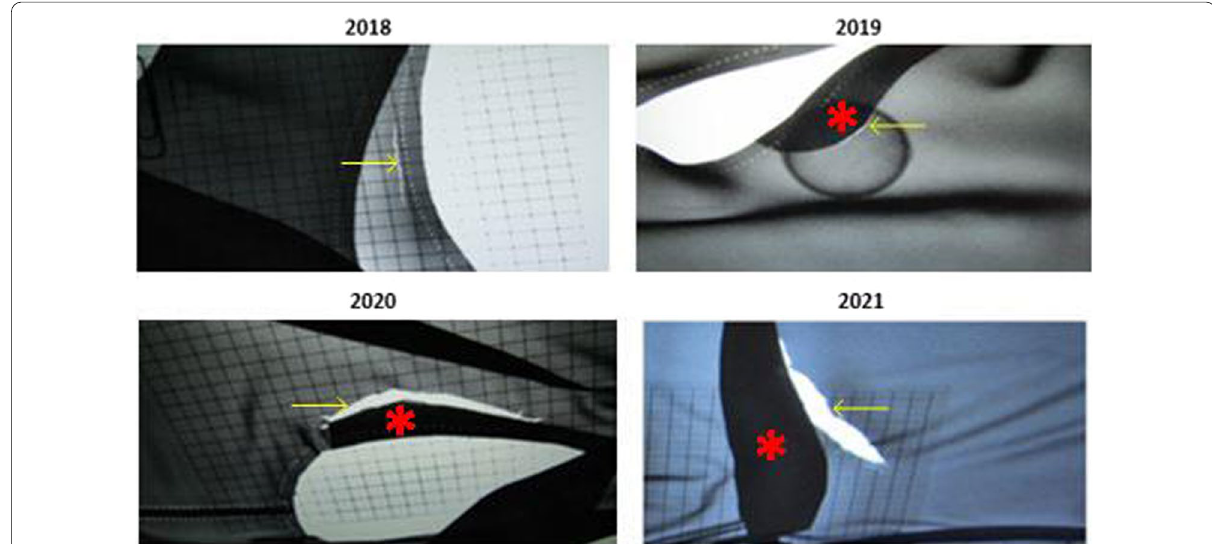
Fig. 2 Tear (yellow arrow) evolution in a lead‑free vest that was sent yearly to the manufacturer for repair. The X‑ray opaque grid to measure the tears is seen in the upper left, bottom left and bottom right picture. The dark patch (red asterisk) is a piece of lead‑free fabric that is placed over the tear at the left arm hole. In 2019, a new tear emerged right beside the repair patch. The round sphere shows the tennis ball to identify the tear more easily. In 2020, after two repairs, a big tear of